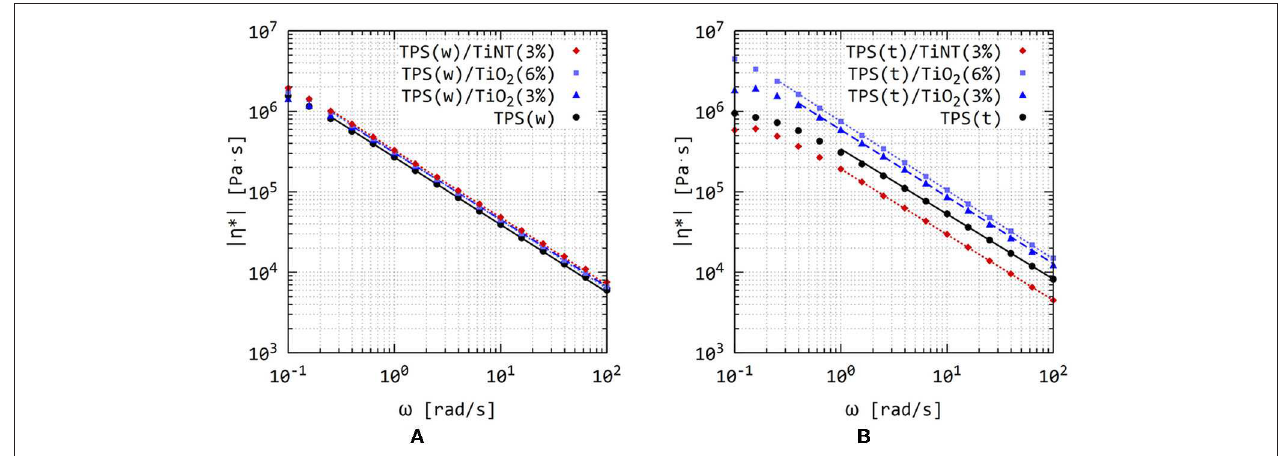
FIGURE 6 | The absolute values of complex viscosities of wheat (A) and tapioca (B) TPS/TiX composites at 120 ◦ C and strain 0.02%: the comparison of the frequency sweeps and their fitting with power-law model (dotted lines; description of the model in Ostafinska et al. (2017).